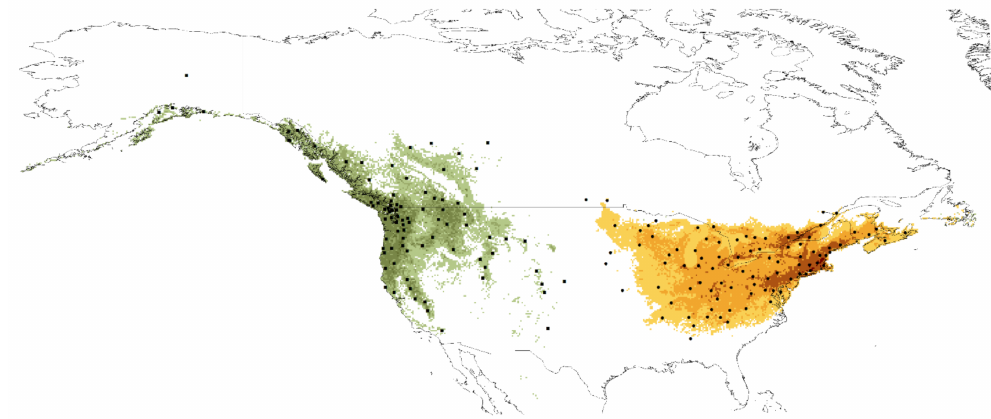
Figure 7. Current distribution of suitable niches of Cucujus clavipes clavipes (orange-brown) and C. c. puniceus (green) and localities used in ENM analyses (dots—subsp. clavipes , squares—subsp. puniceus